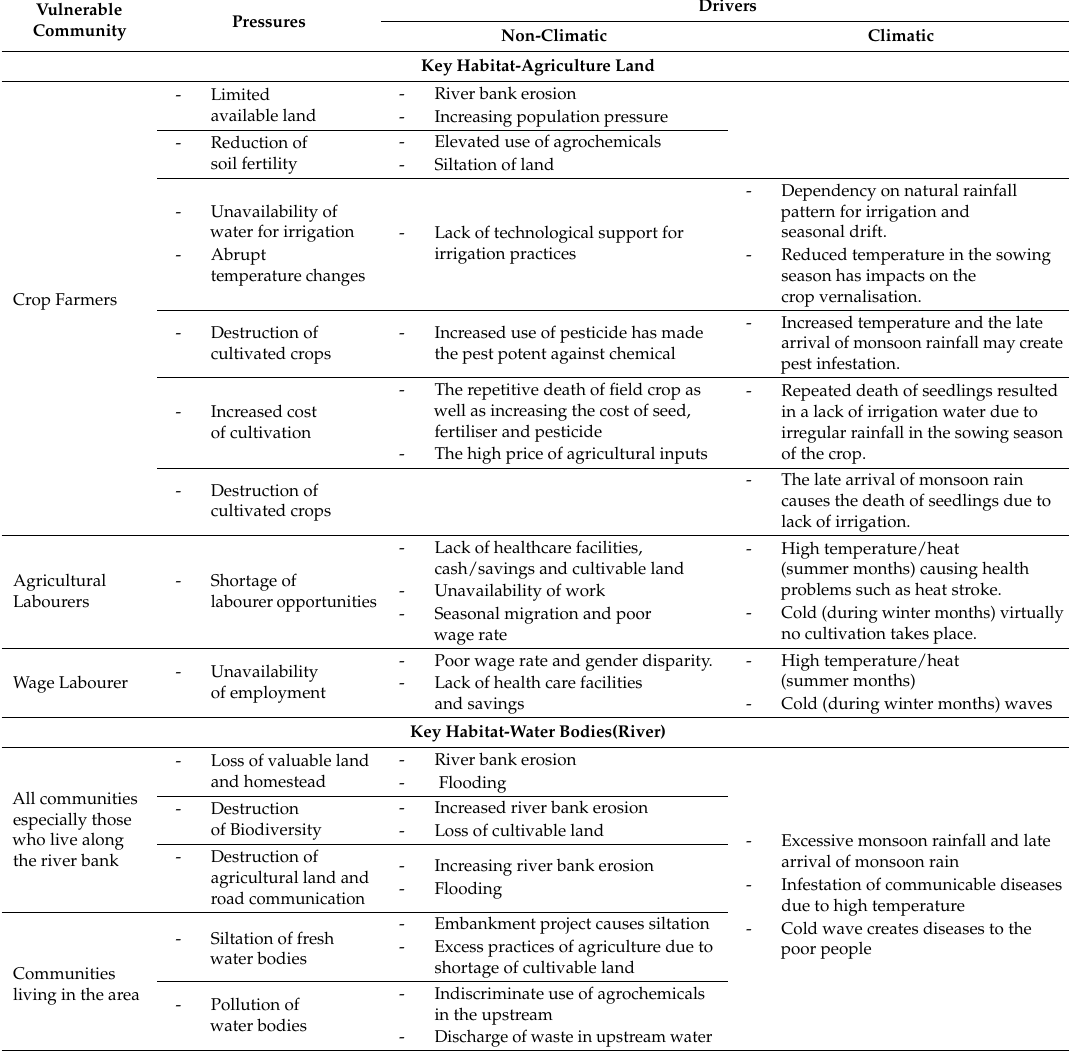
Table 2. Key habitat, vulnerable community, pressures on the ecosystem and drivers in the study